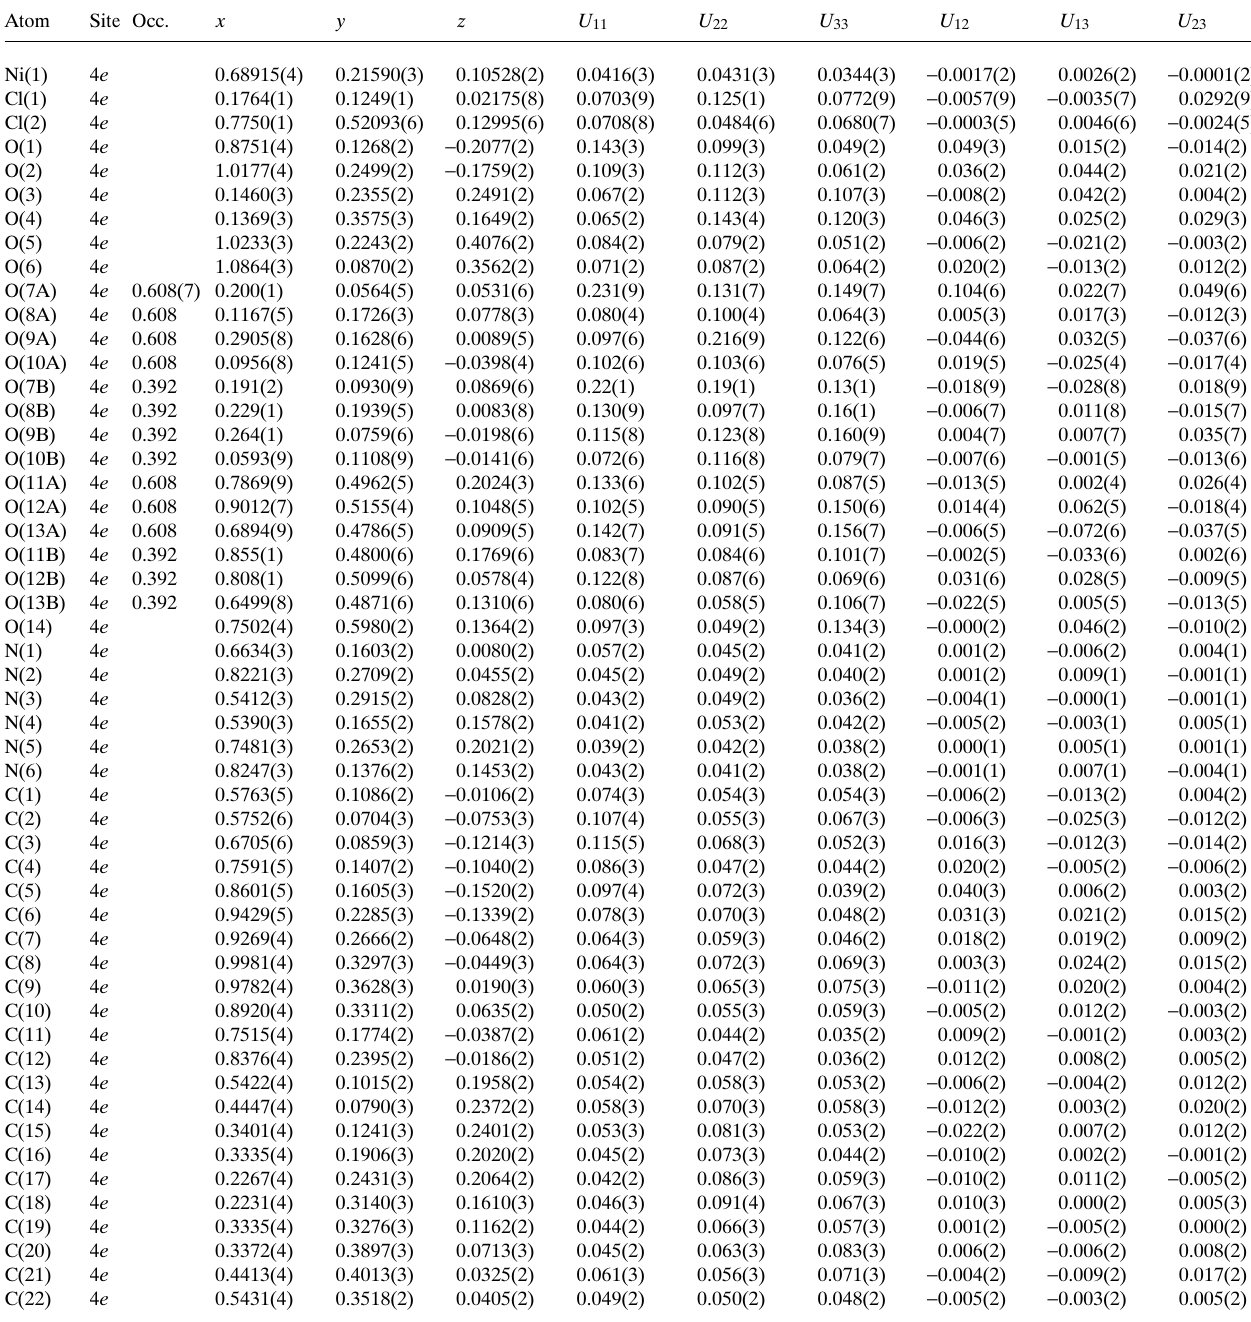
Table 3. Atomic coordinates and displacement parameters (in Å 2 ) .